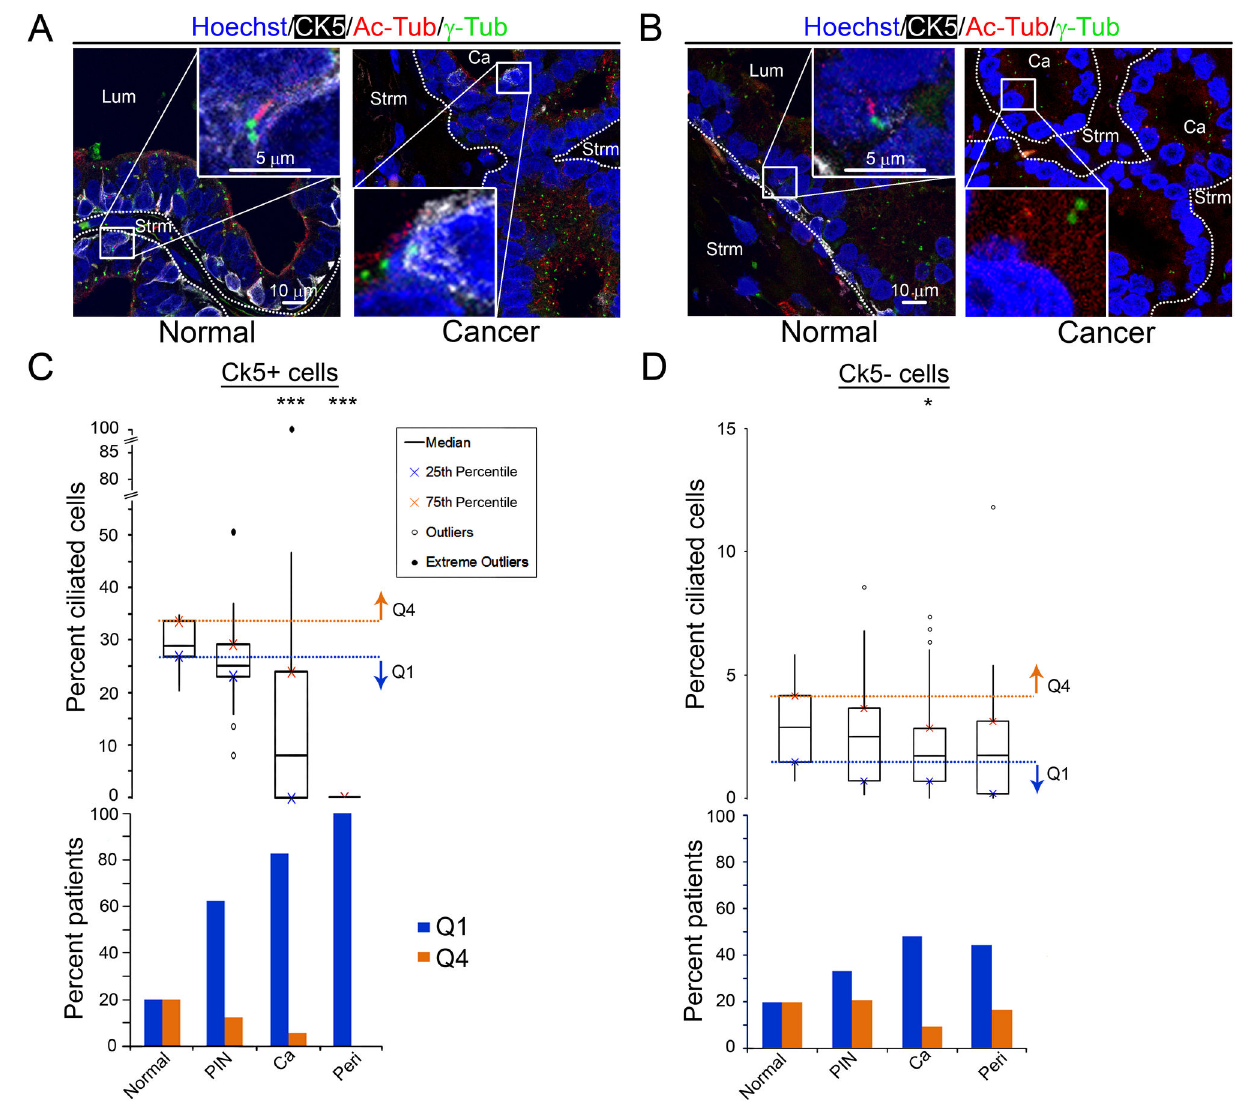
Figure 2. Primary cilia frequency is decreased on both CK5+ and CK5- cancer cells. Images of normal prostate and invasive prostate cancer. Nuclei (Hoechst; blue), cytokeratin 5 (CK5; white), primary cilia (Ac-Tub; red) and centrosomes (γ-Tub; green) are labeled. (A) CK5 marks the basal cell population in normal tissue. (A, left) A ciliated CK5+ normal cell and (A, right) an unciliated CK5+ cancer cell are shown at higher magnification. (B, left) A ciliated CK5- normal cell, and (B, right) an unciliated CK5- cancer cell. (C, top) Boxplots of the percent ciliated CK5+ and (D, top) CK5- epithelial and cancer cells per patient for each tissue type: normal, prostatic intraepithelial neoplasia (PIN), cancer (Ca), and perineural invasion (Peri). Q4, Q1 are as in Fig. 1. Statistics were performed using linear regression (*=p<0.05, ***= p<0.001). (C, bottom) Percent of CK5+ and (D, bottom) CK5- patients with an abnormally high percent cilia (Q4; orange), or an abnormally low percent cilia (Q1; blue).